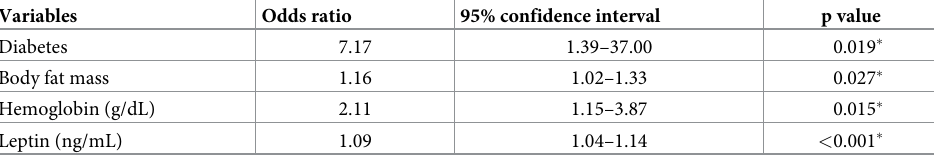
Table 5. Multivariate logistic regression analysis of the factors correlated to arterial stiffness among 112 hemodi- alysis